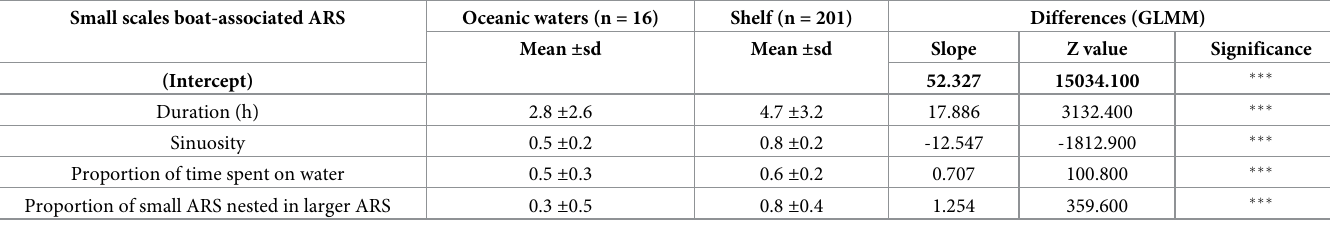
Table 3. Generalised linear mixed model results for differences between small scales ARS with boats detection on shelf or in oceanic waters. Small scales boat-associated